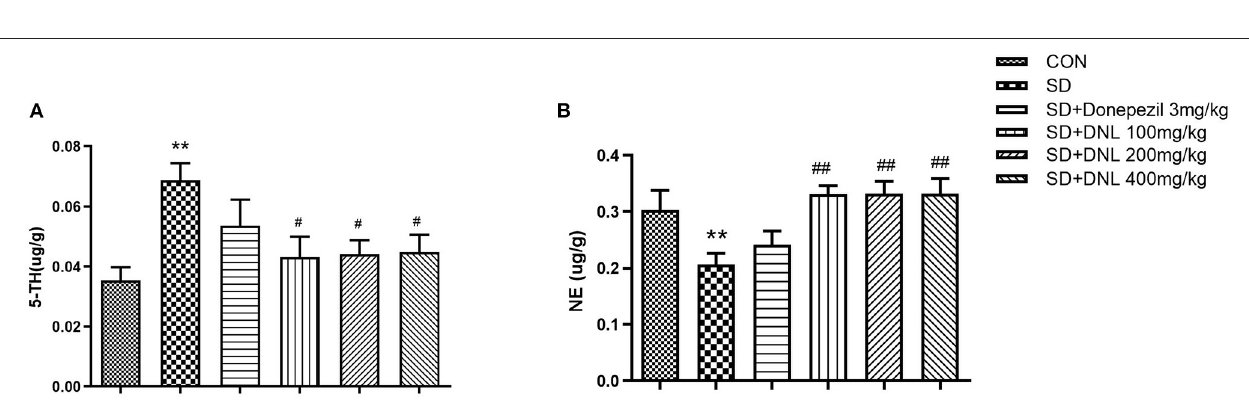
cerebral cortex in the SD group compared with the control group ( p < 0.05) ( Figure 8 ). Compared with the SD mice, brain T-SOD activities in all the DNL-treated groups were increased ( p < 0.05, p < 0.01). DNL (400 mg/kg) treated mice showed a